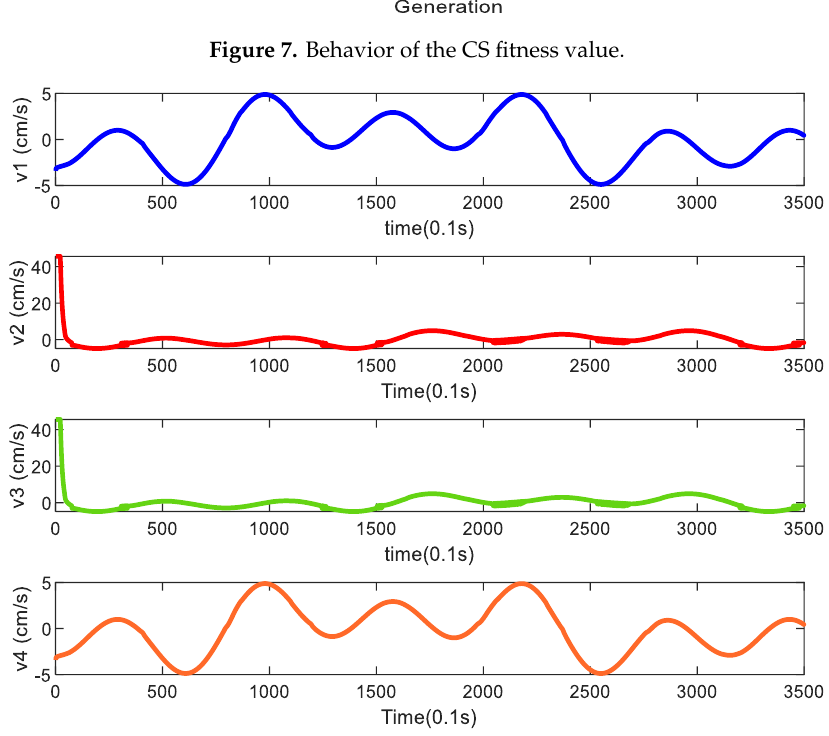
Figure 8. Output commands of the CS-fuzzy controller.